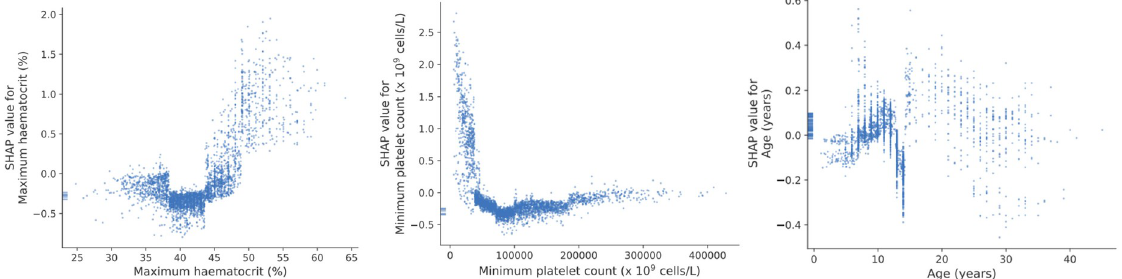
Fig 3. Scatter plot of predictor values (x-axis) against SHAP values (y-axis) in the XGBoost model for haematocrit, platelet count and age. The plot shows a non-linear relationship between predictor values and model output.